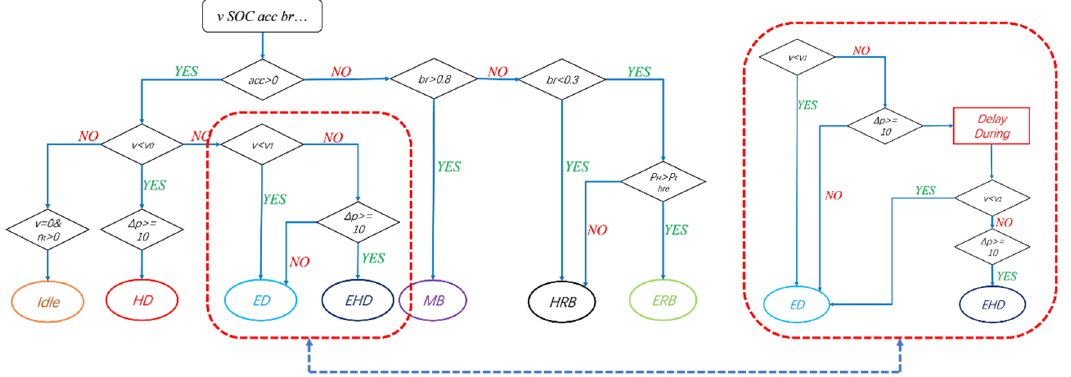
Figure 3. Flow chart for mode switching.